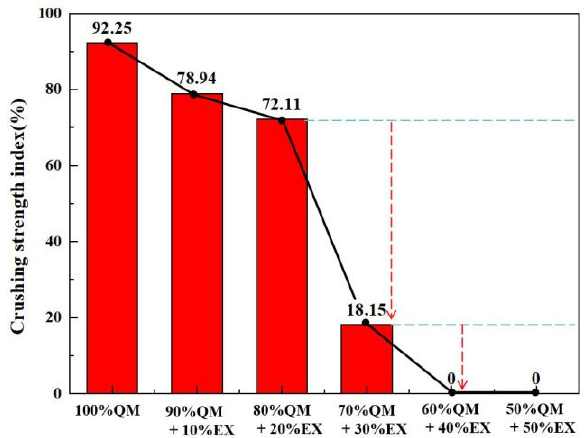
strength for ironmaking.